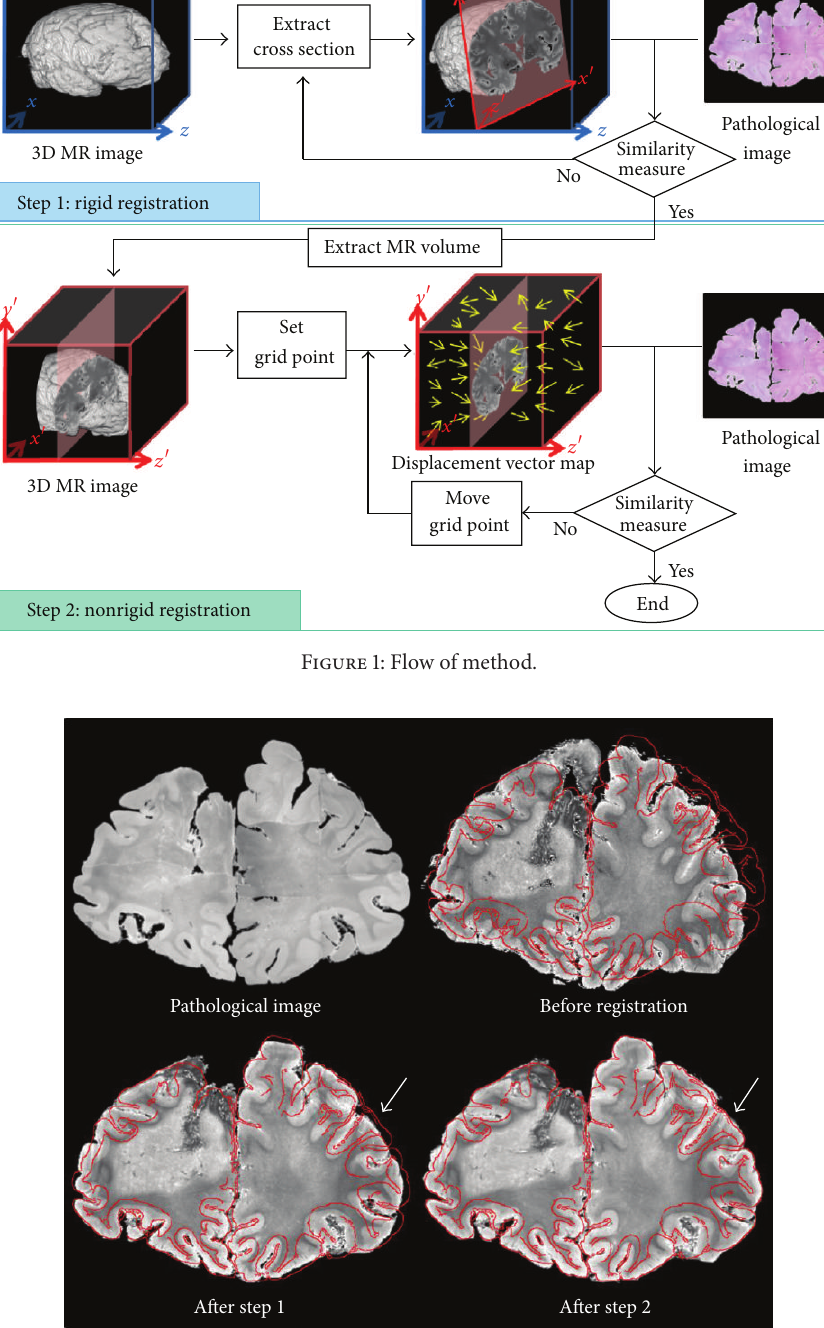
Figure 2: Results of each